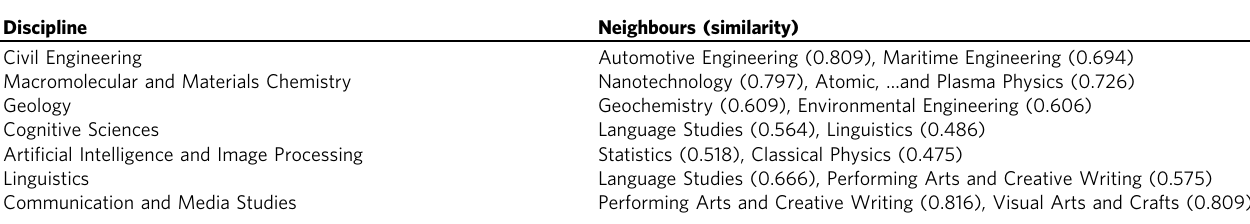
Cosine similarity was calculated with